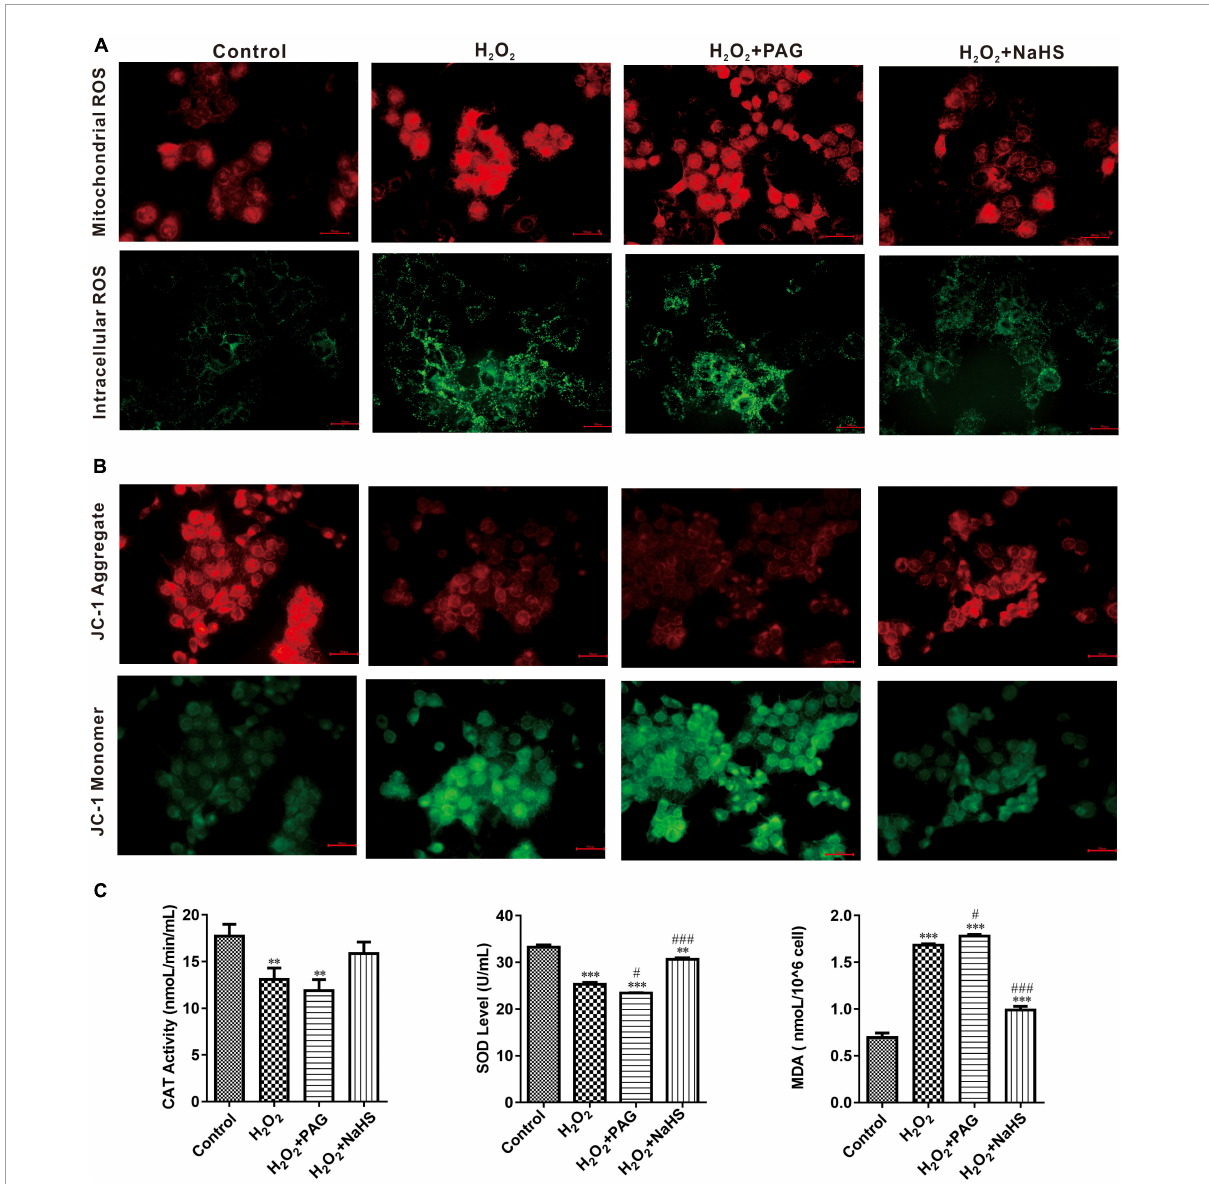
FIGURE4 NaHS inhibited oxidative stress in HTR-8/SVneo cells. (A) The images of different group were obtained with excitation/emission of 525/590 nm for red fluorescence and 490/530 nm for green fluorescence (B) . NaHS decreased mitochondrial membrane potential ( (cid:49)(cid:57) m ) in HTR-8/SVneo cells. Red fluorescence and green fluorescence intensity for JC-1 staining of different groups. Bar = 50 µ m. (C) Effect of NaHS on CAT, SOD and MDA. The data are expressed as mean ± SEM. ∗∗ Vs. Control, P < 0.01. ∗∗∗ Vs. Control, P < 0.001. # Vs. H 2 O 2 , P < 0.05. ### Vs. H 2 O 2 , P <